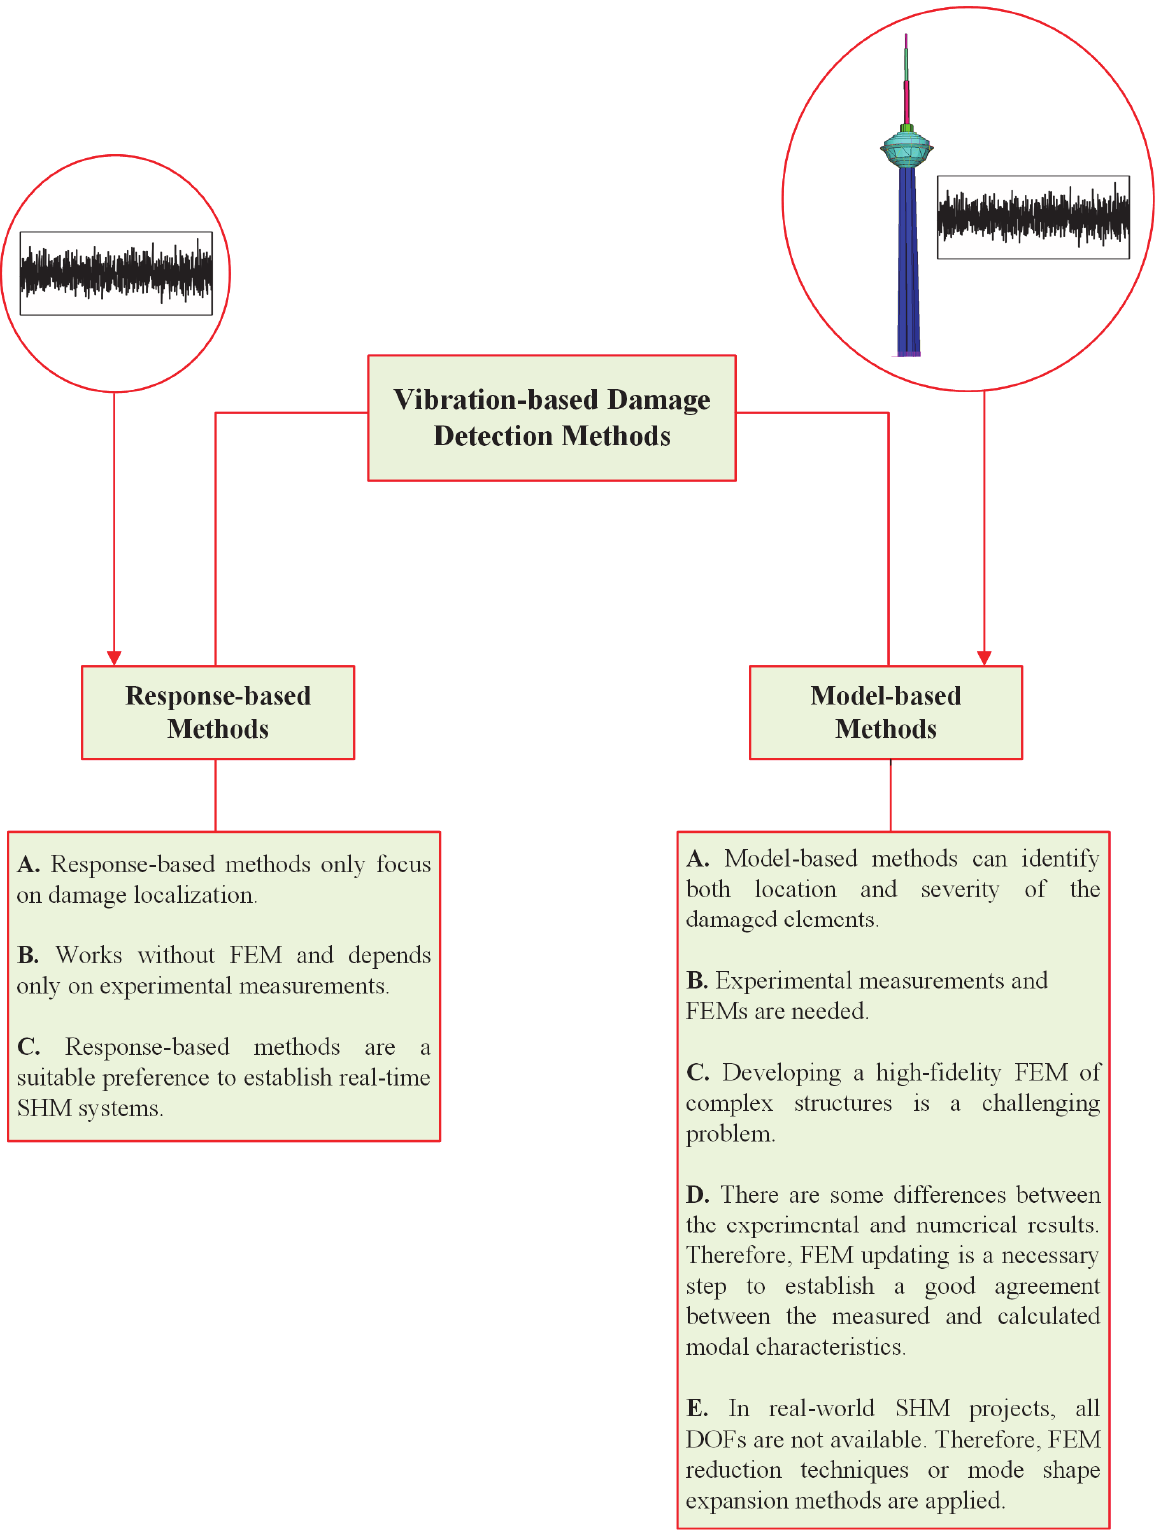
Figure 2: Classification of vibration-based damage detection methods (3D model courtesy of Faham